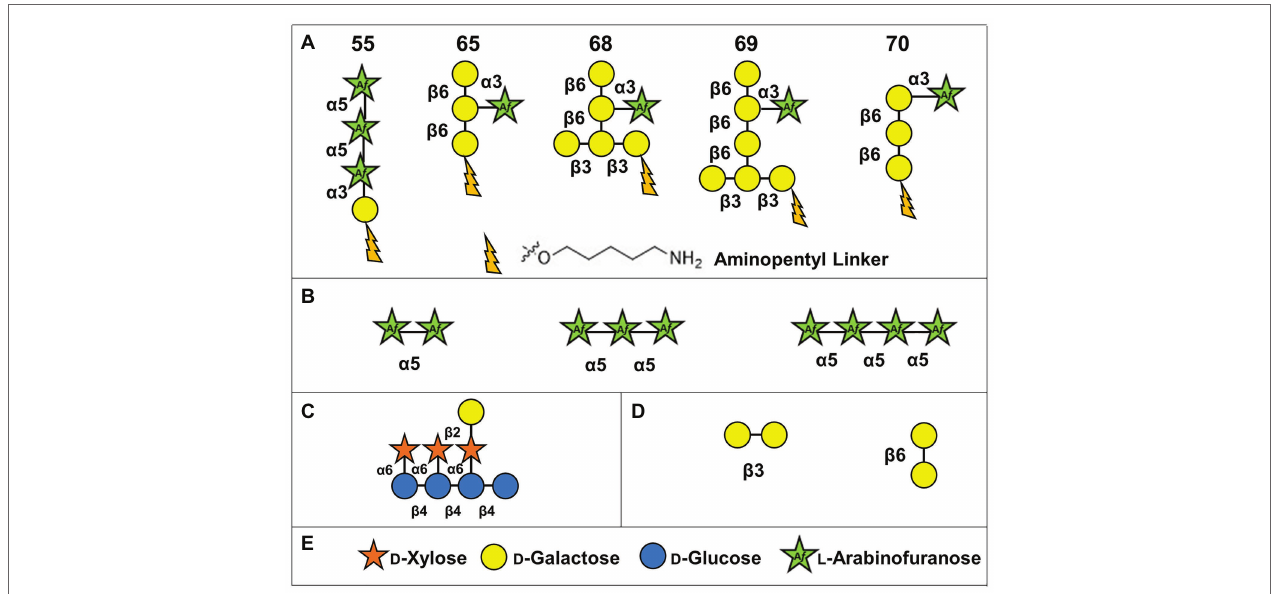
FIGURE 2 | Structures of oligosaccharide acceptor substrates used in this study. (A) Synthetic arabinogalactan oligosaccharides numbered according to Ruprecht et al. (2020). (B) α -(1,5)-linked arabinan oligosaccharides. (C) Xyloglucan XXLG oligosaccharide. (D) β -(1,3)-linked galactobiose and β -(1,6)-linked galactobiose. (E) Symbol